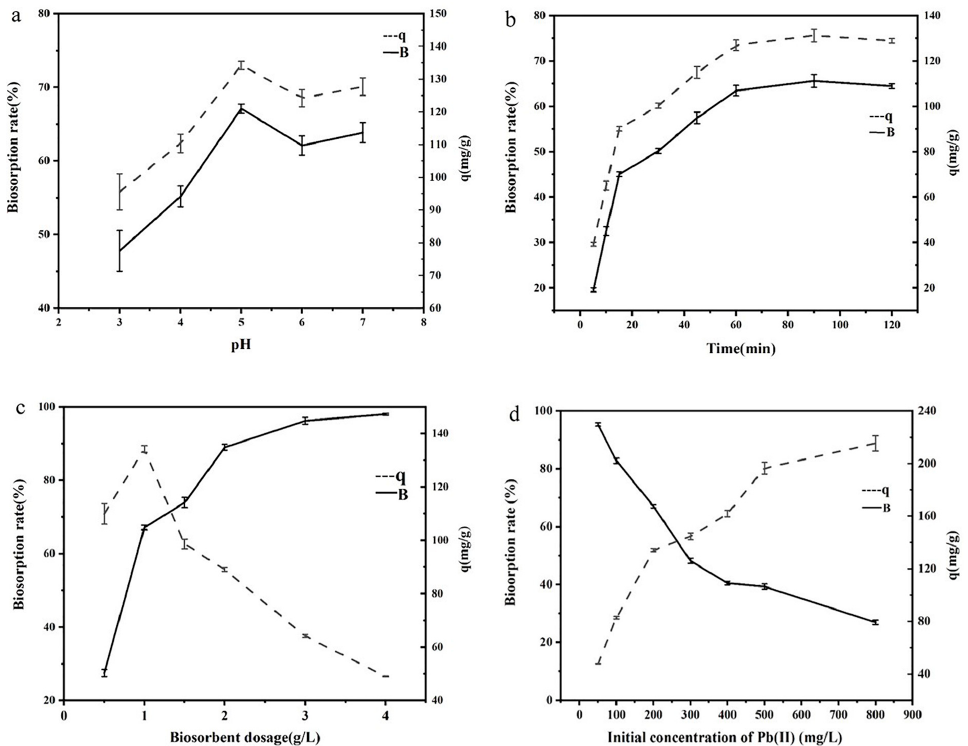
Figure 3. Some parameters influencing the performance of the adsorbent. ( a ) pH, ( b ) contact